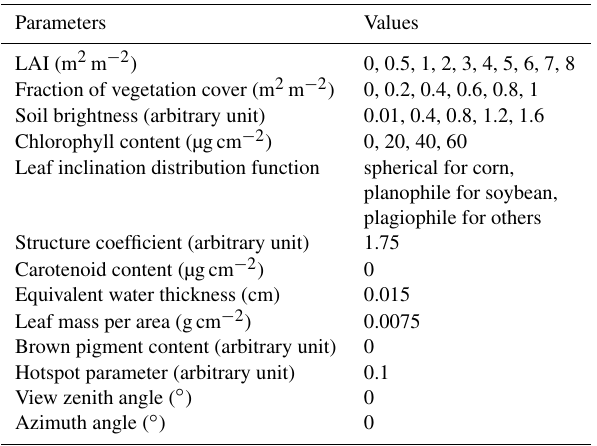
Table 2. Parameter values needed to establish the canopy re- flectance database by